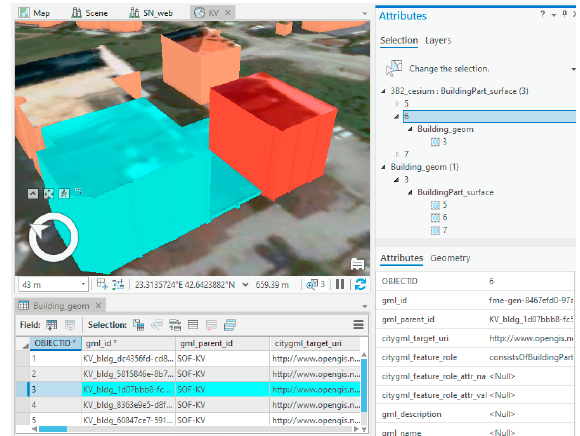
Figure 12. A building with building parts in ArcGIS Pro.